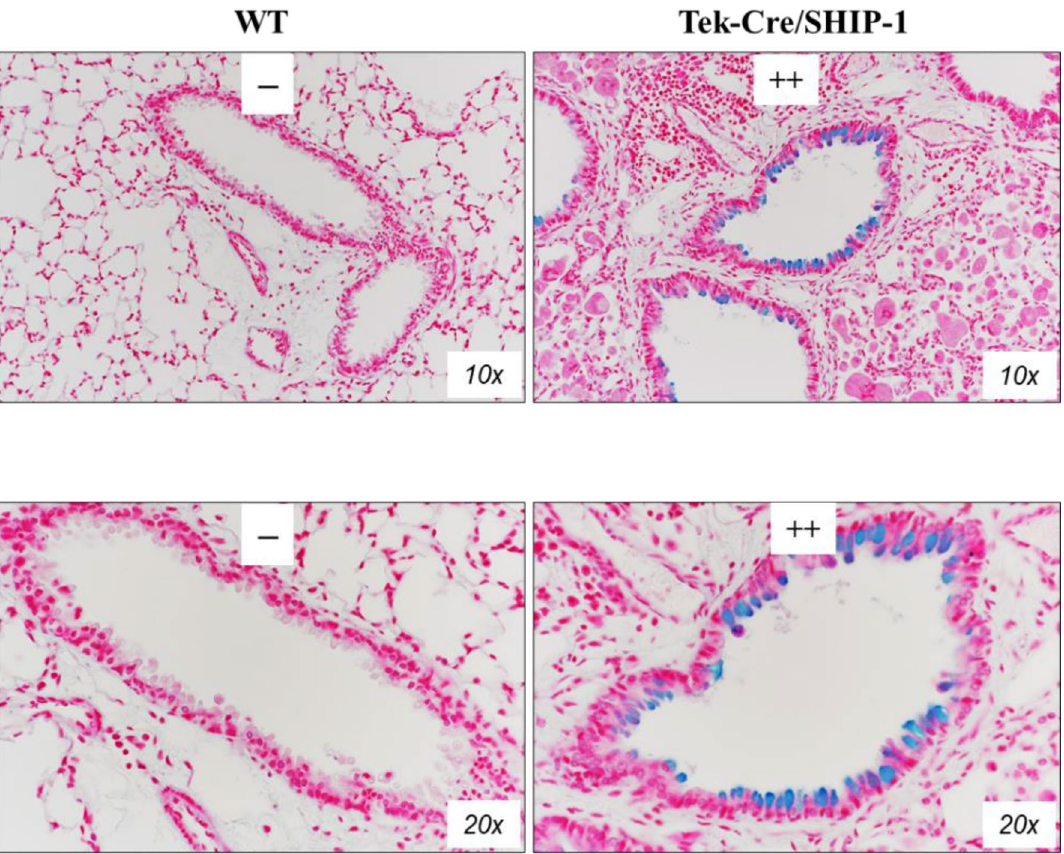
Figure 4. Mucous hyperplasia/metaplasia. Alcian Blue staining of lung sections from WT and Tek-Cre/SHIP-1 mice are shown. Alcian Blue-positive cells in the airways were readily seen in the lung of Tek-Cre/SHIP-1 mice (n = 4 in each group). Pathology scores were assigned by a